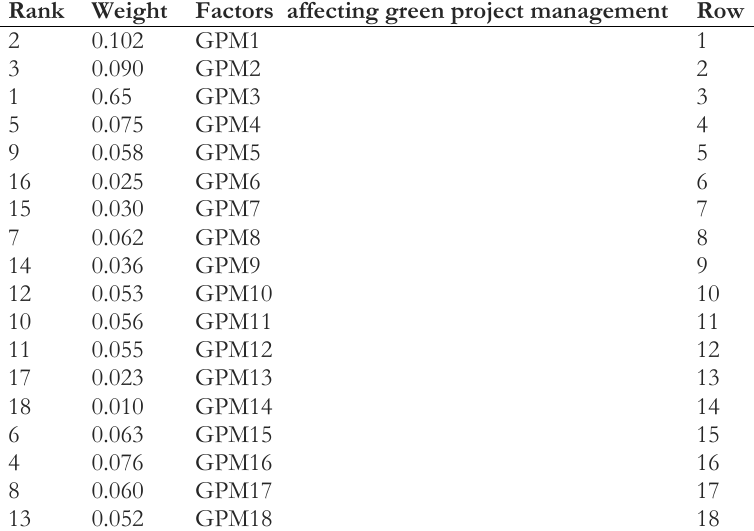
Table 9. Weighting of the